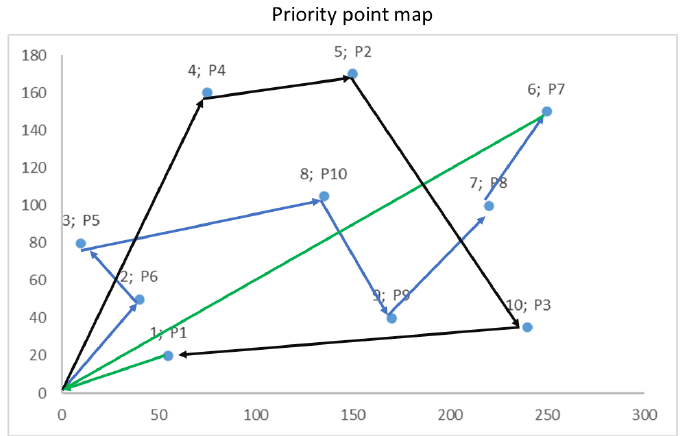
Figure 10. Priority points route (unit: